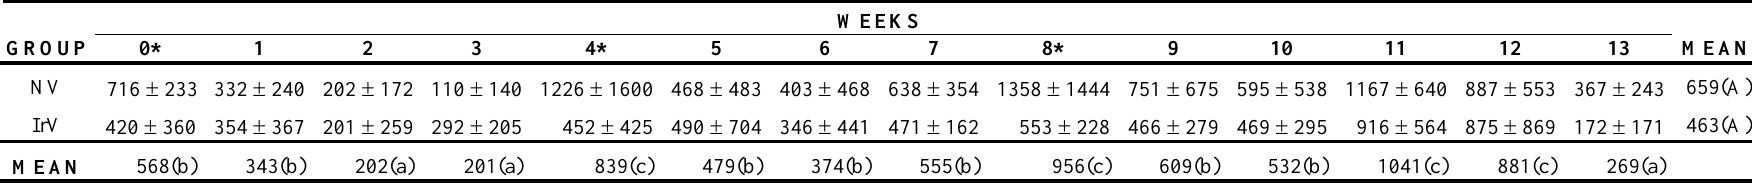
Difference between groups: F=0.97; p>0.10, GI=GII. Difference between times: F=3.90; p<0.05. Interaction: F= 1.03; p>0.05 Different capital letters show significant statistical differences between groups. Different lowercase letters show significant statistical differences between times.